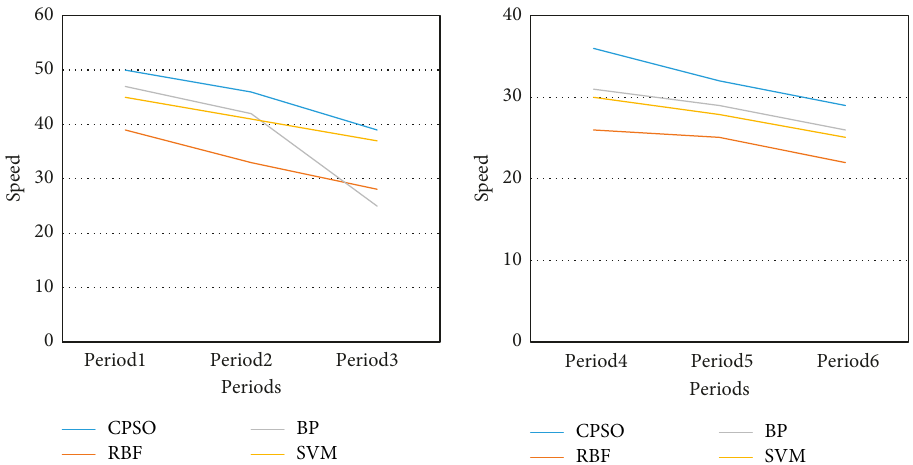
Figure 9: Running speed of CNC machining control